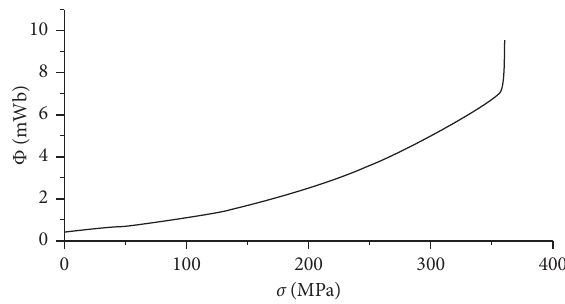
Figure 2: Curve of stress-induced flux